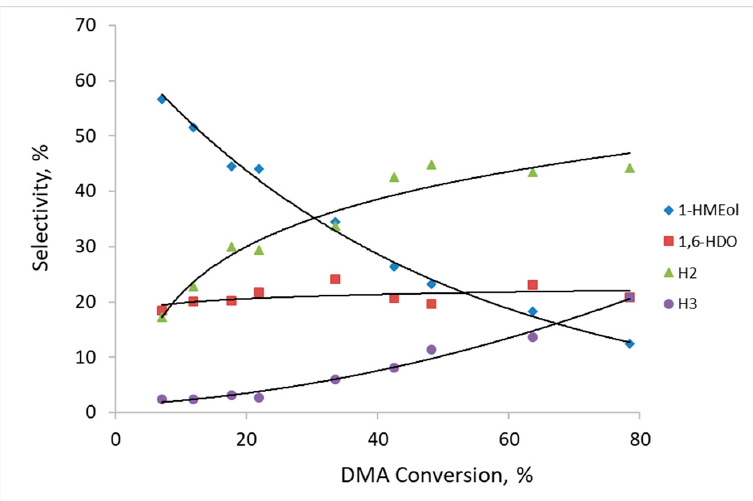
Figure 7. The change of selectivity to the reaction products in dependence on the DMA conversion observed over the catalysts prepared by the calcination of the precursor, CuZn-P, in the air at 220, 350, and 500 °C. 1HMEol is methyl 6-hydroxyhexanoate; 1,6-HDO is hexane-1,6-diol; H2 is the sum of 6-methoxy-6-oxohexyl methyl adipate, 6-hydroxyhexyl methyl adipate, and 6-hydroxyhexyl 6-hydroxyhexanoate; and H3 is the sum of bis(6-methoxy-6-oxohexyl) adipate, 6-hydroxyhexyl (6-methoxy-6-oxohexyl) adipate, and bis(6-hydroxyhexyl) adipate.